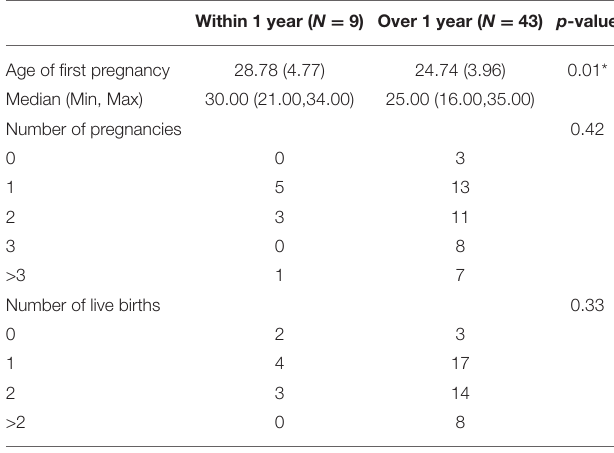
TABLE 2 | Comparison of the clinical characteristics between patients with ALS within 1 year and over 1 year between pregnancy and symptom onset.